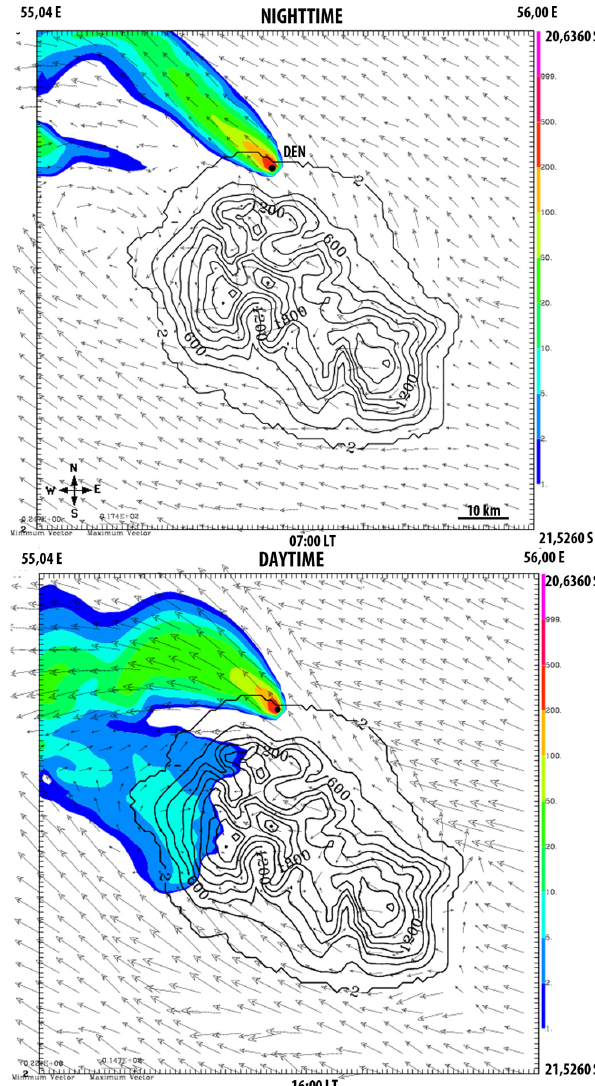
Fig. 14. ALIZ10 – horizontal field of the tracer dilution ratio (per mil of the concentration at emission point) at the first model level above the ground, emitted from BRG, at 11:00LT (top) and 15:00LT (bottom).